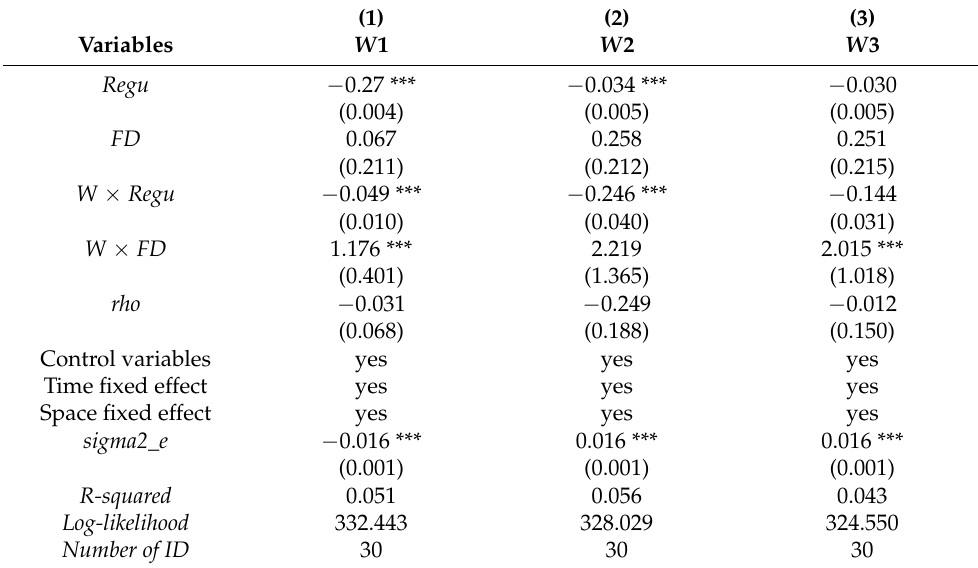
Table 12. Robustness test results under each spatial weight matrix after the tailing process.